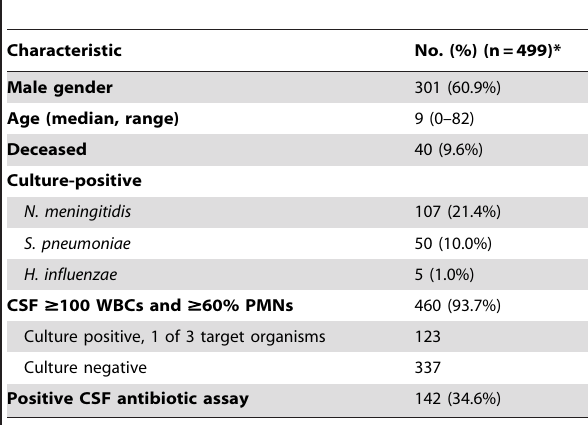
Table 1. Characteristics of patients included in the